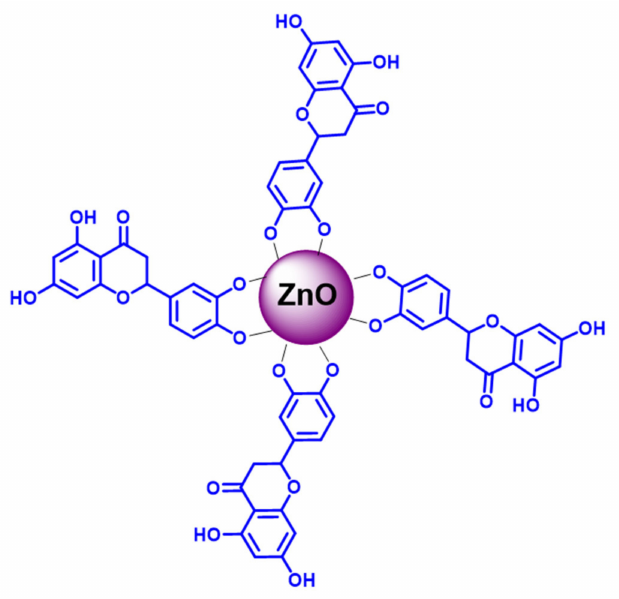
Figure 2. Tentative representation of as-obtained luteolin-functionalized ZnO nanoparticles